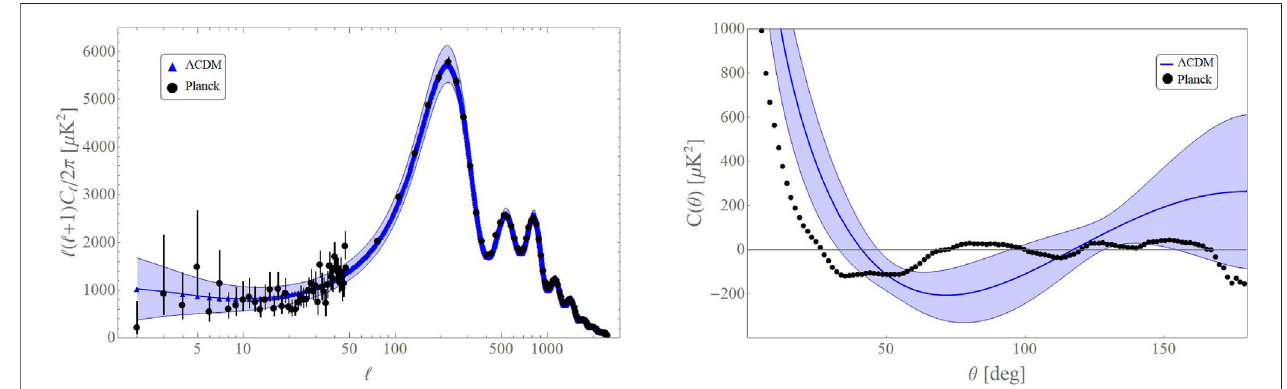
FIGURE2| The TT power spectrum inthemultipole (A) and angular space (B) generated inthe standard modelcorrespondingtothe best fi tparameters provided by Planck. The blue shaded region indicates the uncertainty due to cosmic variance. The black dots with error bars are the data from Planck. Note that the observed quadrupole is quite low compared to the prediction from the standard model, although it is compatible with the prediction within 1 σ when we account for cosmic variance. The lack of power at large angular scales is more evident in the angular power spectrum, where the power is considerably low for angular scales greater than 60 ° . Furthermore, the amplitude of the predicted power islarger than the observed one by more than 1 σ for the largest angular scales and for angles between ≈ 60 ° and 80 °